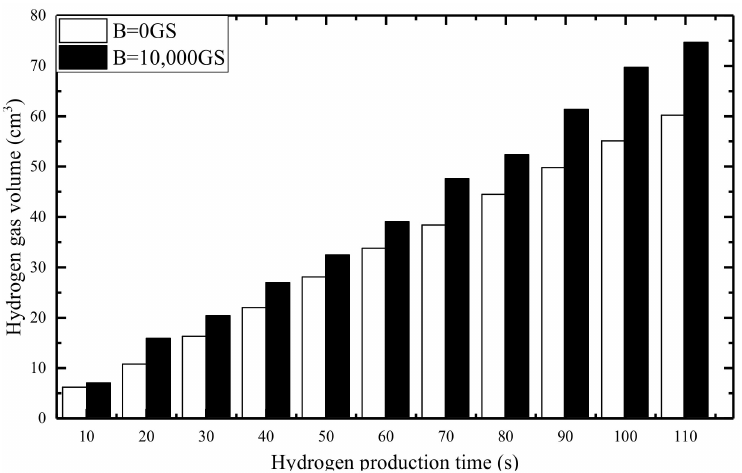
Figure 10. Comparison of hydrogen production of distilled water without pre-polarization and after 10,000 GS magnetic field